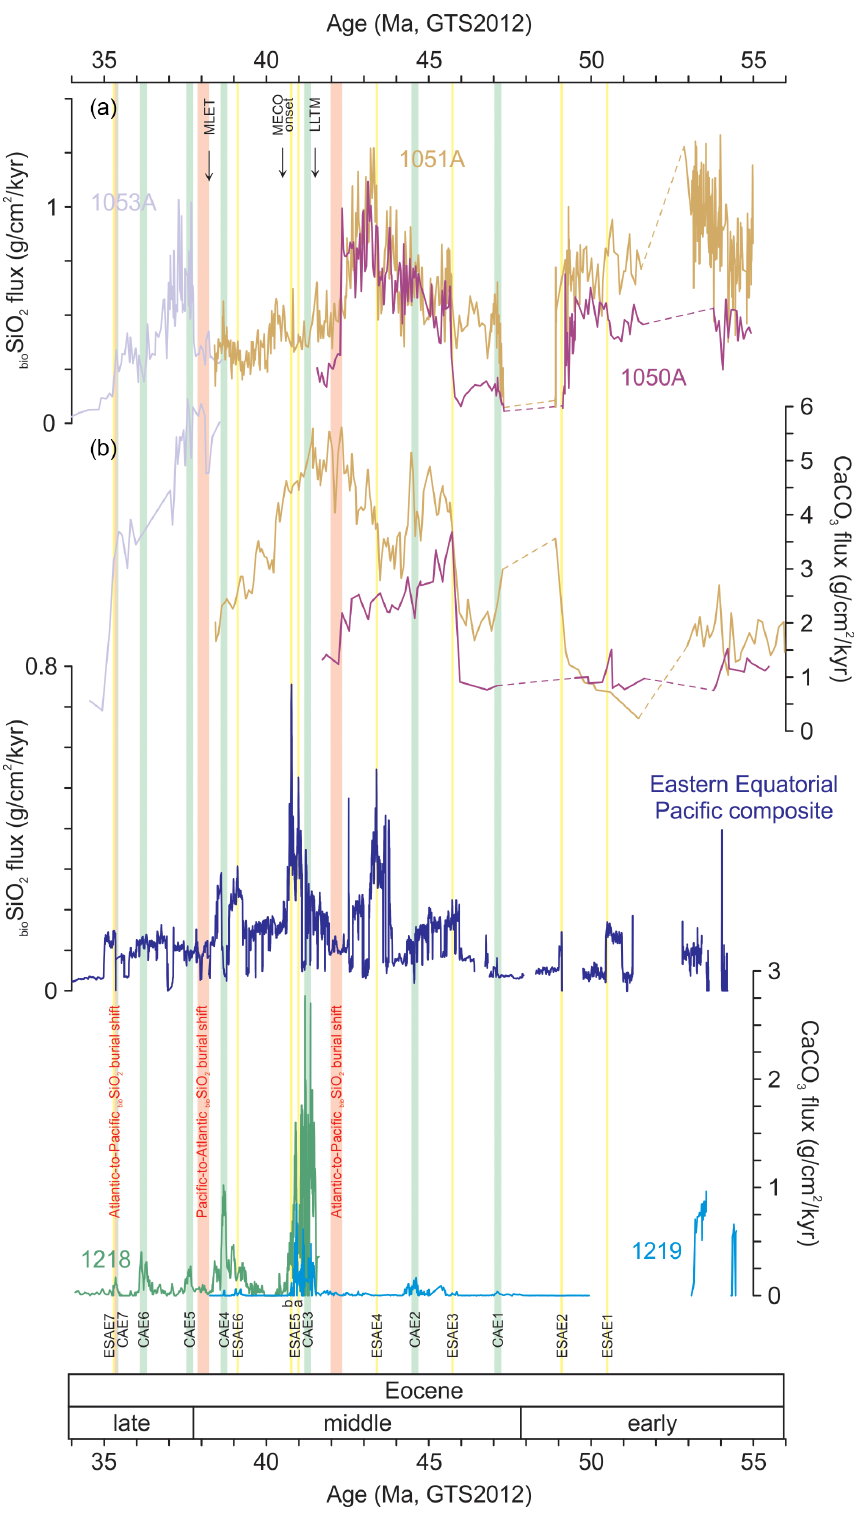
Figure 4. Eocene biogenic silica (a) and calcium carbonate (b) fluxes at Blake Nose sites plotted against biogenic silica (c) and calcium carbonate (d) fluxes at eastern equatorial Pacific sites. Blake Nose carbonate data are from Shipboard Scientific Party (1998c, d, f). Eastern equatorial Pacific data are from Moore et al. (2008) and Lyle et al. (2005). Abbreviations: bio SiO 2 – biogenic silica; GTS2012 – Geologic Time Scale 2012 (see Gradstein et al., 2012); MLET – Middle–Late Eocene Turnover; LLTM – Late Lutetian Thermal Maximum; ESAE – Eocene silica accumulation event; CAE – carbonate accumulation